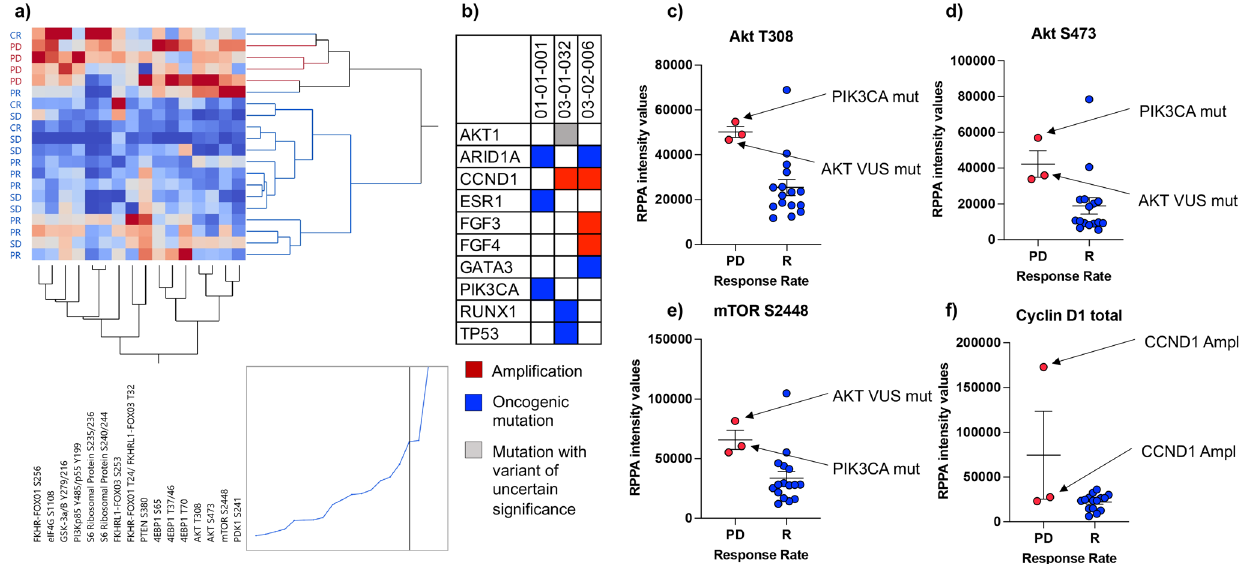
Fig. 4 Correlation between oncogenic genomic alterations and protein expression/activation in patients with progressive disease. Unsupervised hierarchical clustering analysis using Ward ’ s method of members of the PI3K/AKT/mTOR signaling pathway shows increased activity and clustering of tumor epithelia collected from patients that developed disease progression ( a ). NGS-based analysis of the recurrent lesions at disease progression for three of the four patients with progressive disease identi fi ed an oncogenic mutation of PIK3CA in one patient and ampli fi cation of the CCND1 gene in the remaining two patients ( b ). Increased activation levels of AKT and mTOR detected in patients with progressive disease did not correlate with the underlying genotype ( c – e ). Similarly, the expression of Cyclin D1 did not directly correlate with CCND1 ampli fi cation ( f ).